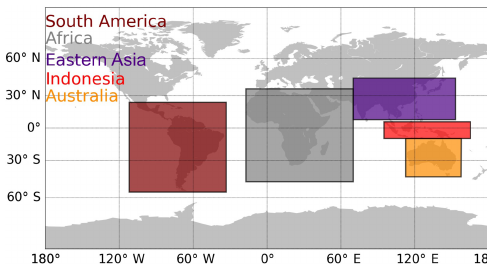
Figure 2. GEOS-Chem tagged regions used for anthropogenic and biomass burning sources in the CO simulation. South America (56 ◦ S–24 ◦ N, 112–33 ◦ W), Africa (48 ◦ S–36 ◦ N, 17 ◦ W–70 ◦ E), East Asia (8–45 ◦ N, 70–153 ◦ E), Indonesia (10 ◦ S–6 ◦ N, 95– 165 ◦ E) and Australia (44–10 ◦ S, 112.5–157.7 ◦ E). The East Asia and Indonesia regions were used for the biomass burning source only. Regions not shown on the map are anthropogenic other and biomass burning other; these are regional tags that cover everything except the source specific tagged